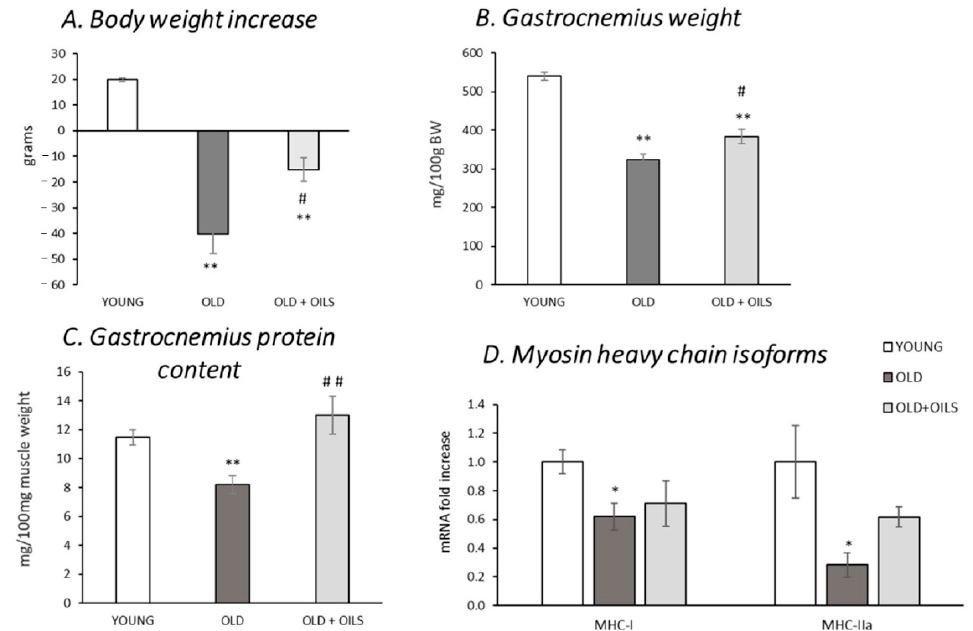
Figure 1. Beneficial effects of oil mixture on body weight gain ( A ), gastrocnemius muscle relative weight ( B ), gastrocnemius muscle protein concentration ( C ), and gastrocnemius mRNA levels of myosin heavy chain isoforms (MHC) I and IIa ( D ). Values are represented as mean ± standard error of the mean (SEM) of young rats ( n = 11), old rats ( n = 8), and old rats treated for 21 days with the oil mixture (OLD + OILS, n = 5). Statistics: ** p < 0.01 and * p < 0.05 vs. Young; ## p < 0.01 and # p < 0.05 vs. Old, by least-significant difference post hoc analysis after significant one-way analysis of variance (ANOVA).